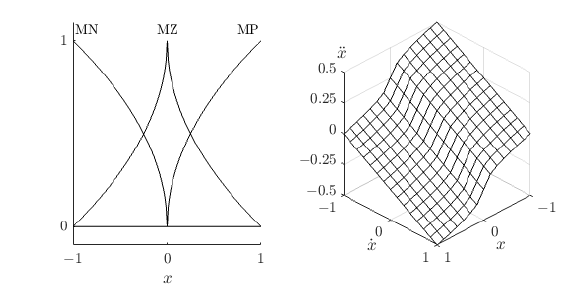
Figure 14. The dilation of the input membership functions x and the resultant inference